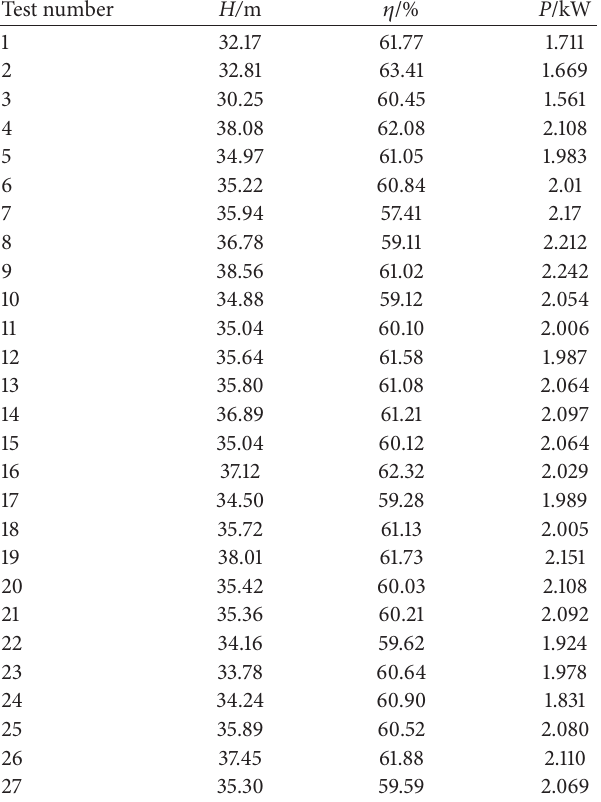
Table 8: Simulation